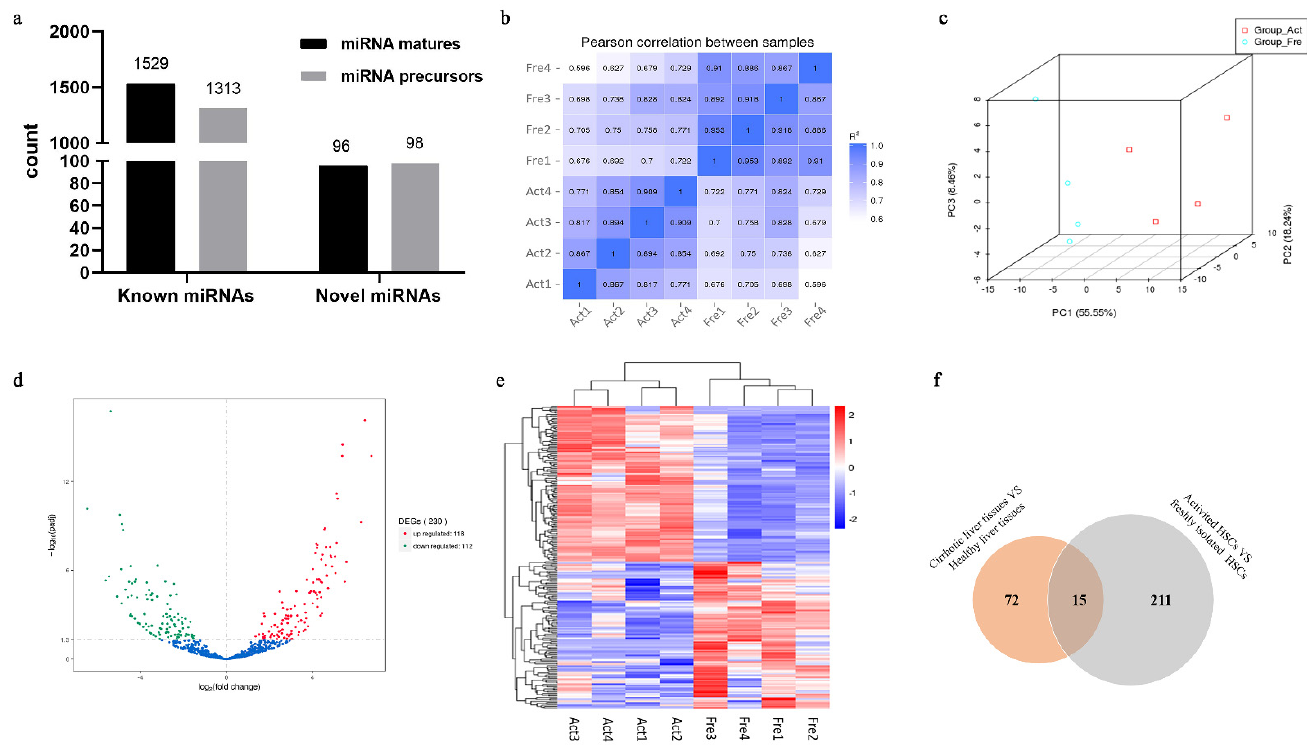
Figure 3. Evaluation of sequencing data and identification of candidate DEmiRNAs. ( a ) The number of miRNA matures and precursors from sequencing. ( b ) Pearson correlation heat-map of miRNA expression in different samples. R 2 —The square of Pearson’s correlation coefficients. ( c ) PCA plot between groups. Each point represents one sample. The red square represents a sample from Group_Act and the blue circle represents a sample from Group_Fre. ( d ) Volcano plot of miRNAs differentially expressed between Group_Fre and Group_Act. Each point represents one detectable miRNA. ( e ) Cluster of 230 DEmiRNAs between groups. Log10 (TPM + 1) values were used for clustering. ( f ) A Venn diagram of miRNA-seq data for HSCs and liver tissues. Four novel miRNAs in our data were not considered. Differentially expressed microRNAs, DEmiRNAs; principal component analysis, PCA; hepatic stellate cells, HSCs; microRNA sequencing, miRNA-seq; versus,